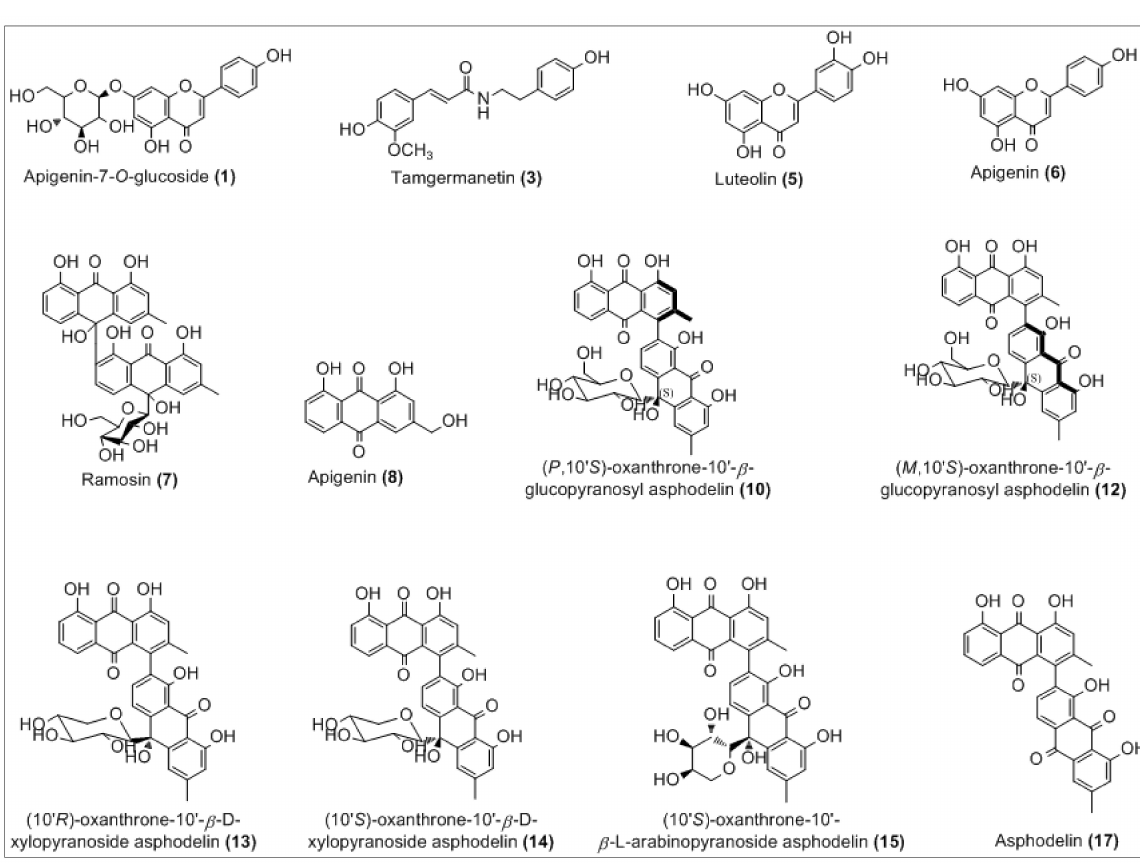
Figure 2. Chemical structures of the tentatively identified